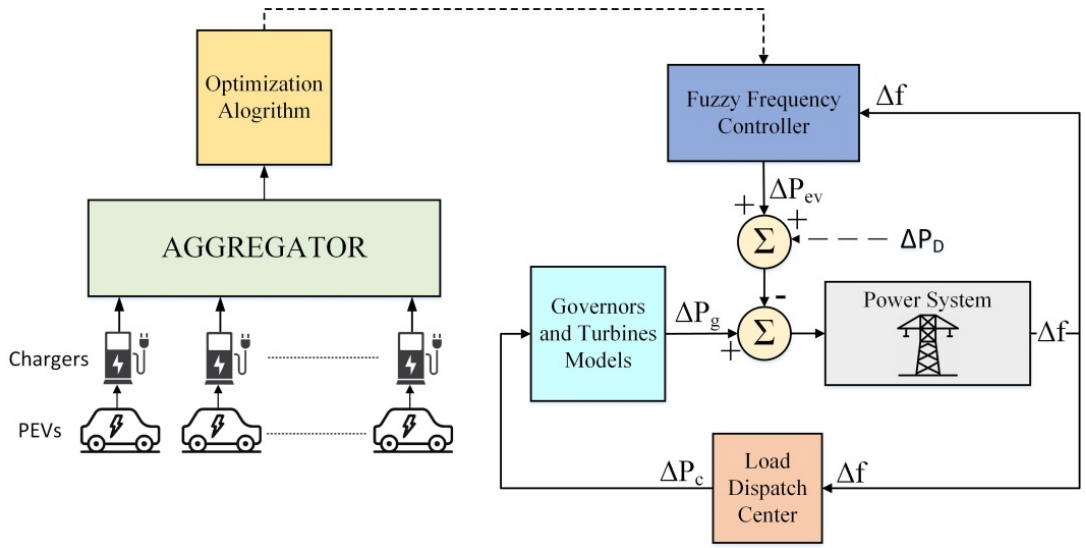
Figure 4. Simplified diagram of system frequency control supported by the PEV aggregator.